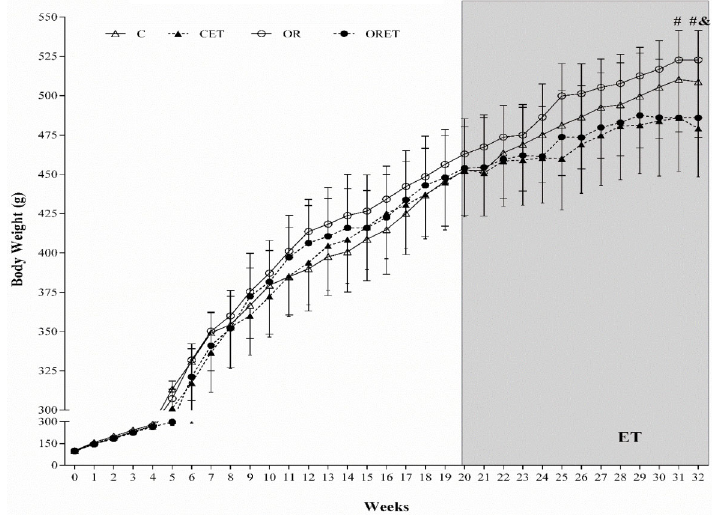
Figure 4. Evolution of body weight during the period of exposure to diet and aerobic exercise training (ET) protocol. Control group (C, n=12), exercised control (CET, n=14), obese-resistant (OR, n=9), and obese-resistant exercised (ORET, n=10). Data are reported as means ± SD. # P o 0.05 ORET vs OR; & P o 0.05 CET vs C (repeated measures two-way ANOVA followed by Bonferroni ’ s post hoc test).